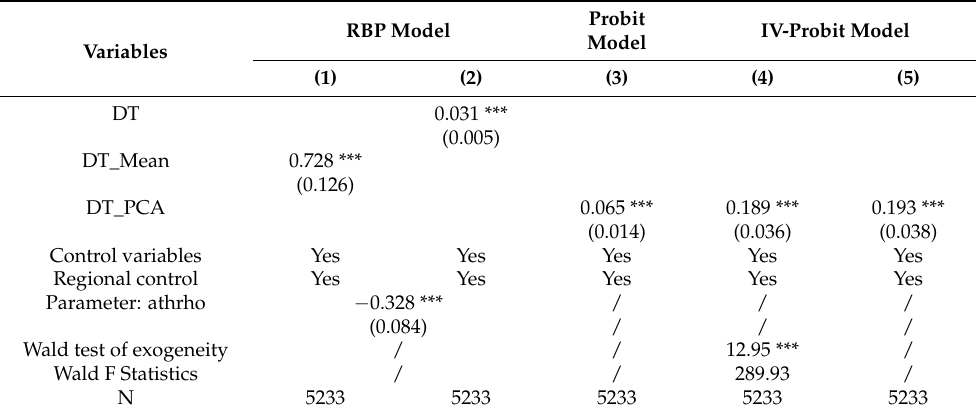
Table 4. Robustness test results for DT’s impact on LRB.